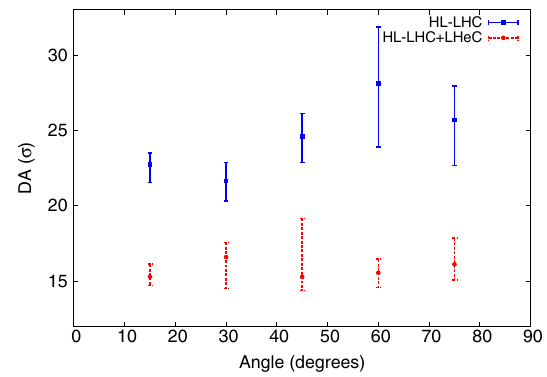
FIG. 15. Comparison of beam 2 DA between the round optics of the HLLHCV1.0 version of the HL-LHC ( β with the LHeC insertion with β (cid:1) ¼ 10 cm and L (cid:1) ¼ 10 m in